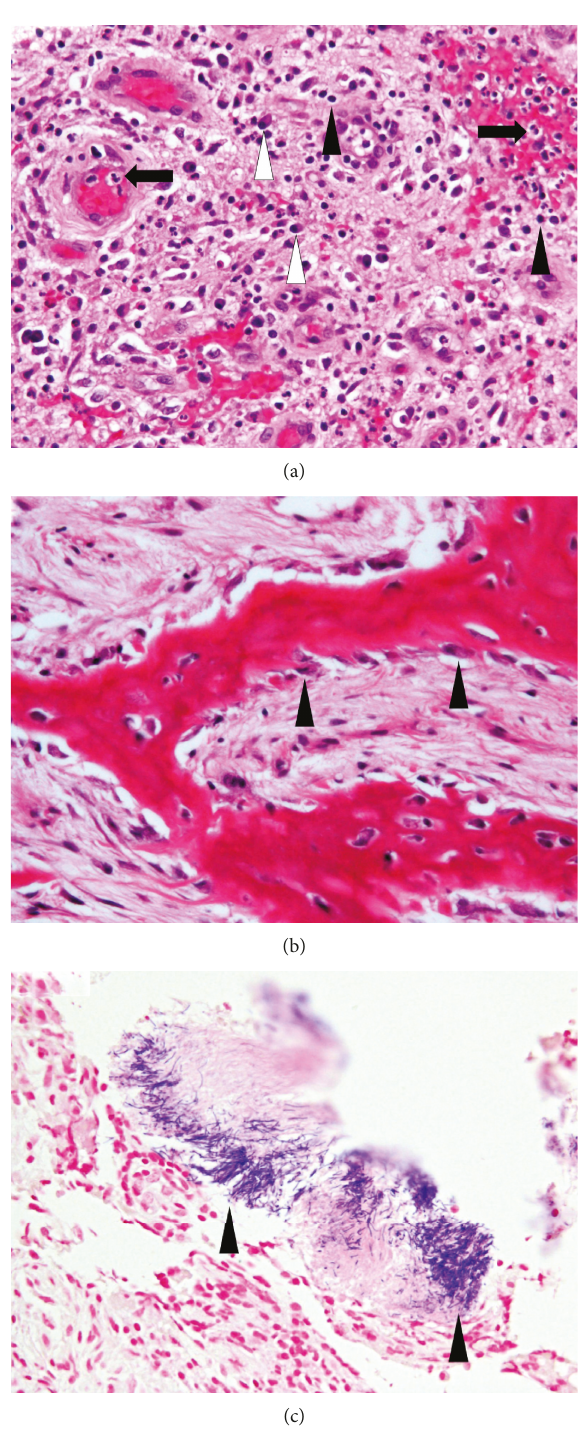
Figure 7: Surgical specimen of the granulation tissue. (a) The majority of the surgical specimen is granulation tissue composed of lymphocytes (black arrowheads) and plasma cells (white arrowheads), with neutrophil in fi ltration (black arrows) (H-E, × 400). (b) The surgical specimen includes neonatal bone accompanied by many osteoblasts (black arrowheads) (H-E, × 400). (c) Colonies of Actinomyces sp. (black arrowheads) are recognized in the in fl ammatory in fi ltrates (Gram, × 400).